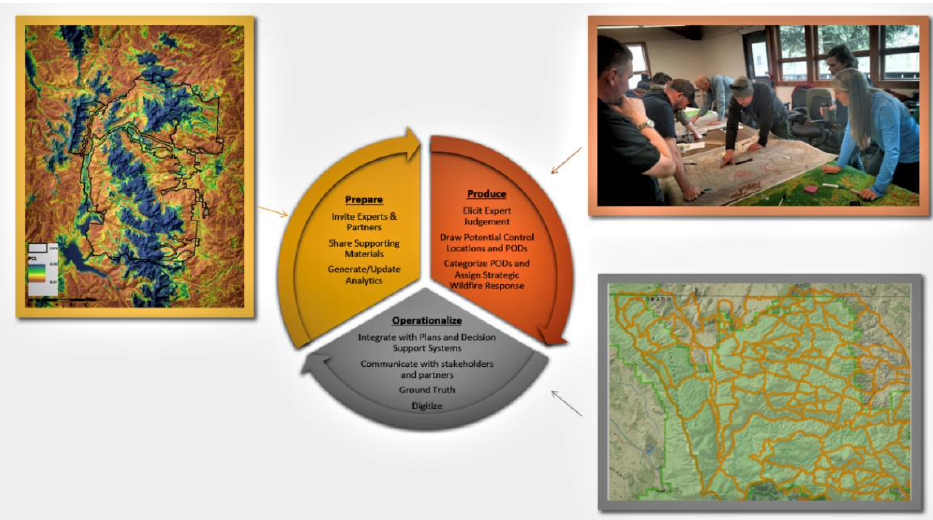
Figure 2. General workflow of the potential wildland fire operational delineation (POD) development process, with figure insets for each stage displaying real-world examples of generated potential control locations (PCL) layers (prepare), manager workshops (produce), and final POD maps (operationalize) [41].